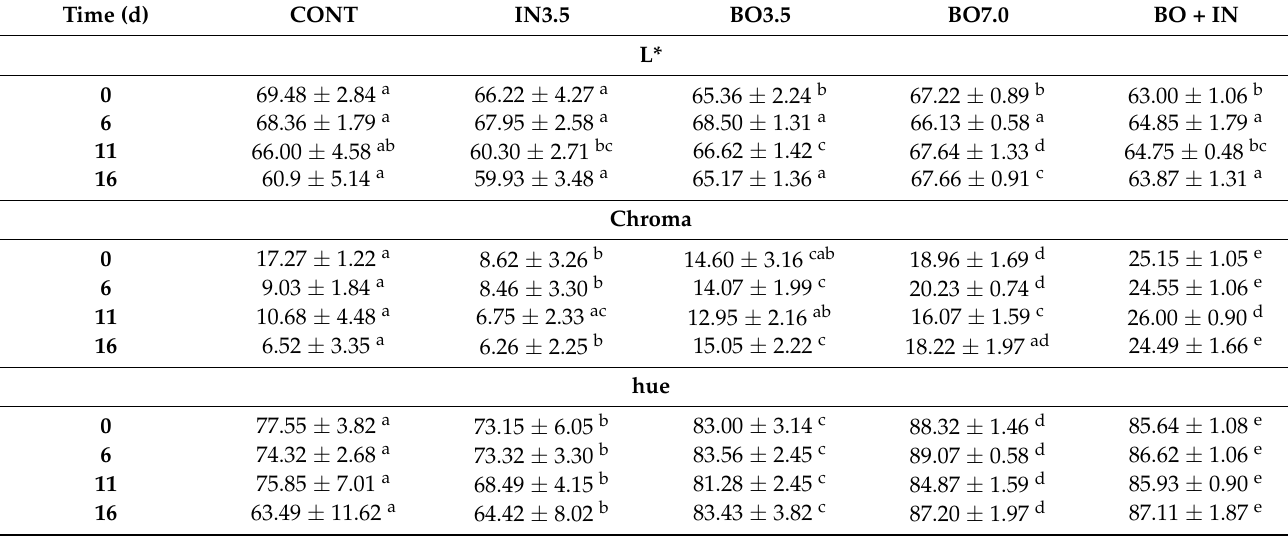
CONT, without adding ingredients; IN3.5: with the addition of 3.5% inulin ( m / v ); BO3.5: with the addition of 3.5% bocai ú va powder-pulp ( m / v ); BO7.0: with the addition of 7.0% bocai ú va powder-pulp ( m / v ); and BO+IN: addition of 3.5% inulin + 3.5% bocai ú va powder-pulp. Different letters indicate a statistical difference between the fermented beverages during the shelf life by the Tukey test ( p <